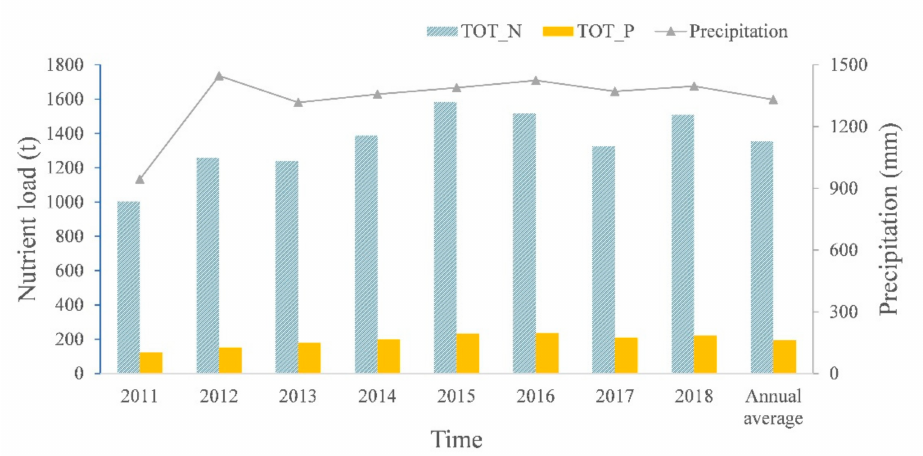
Figure 7. TOT_N and TOT_P of MLW from 2011 to 2018.